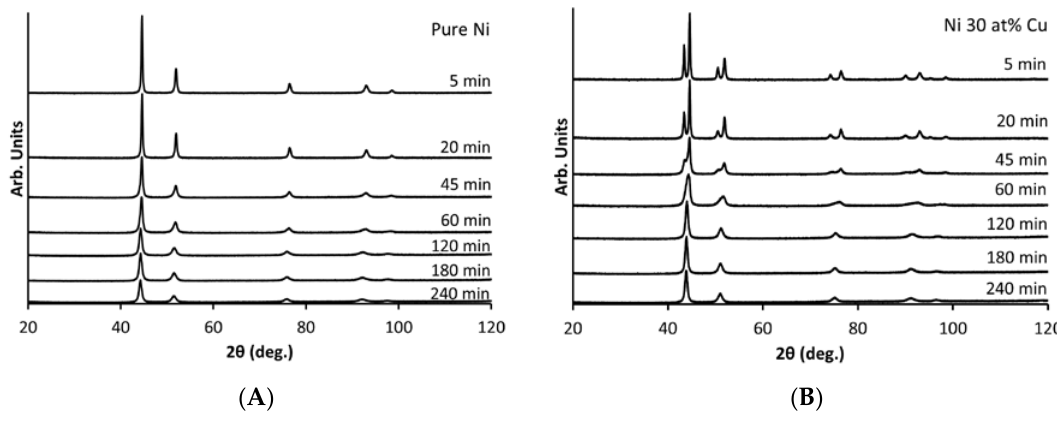
Figure 1. XRD patterns collected after listed milling times for ( A ) Pure nickel and ( B ) Ni 30 at % Cu.